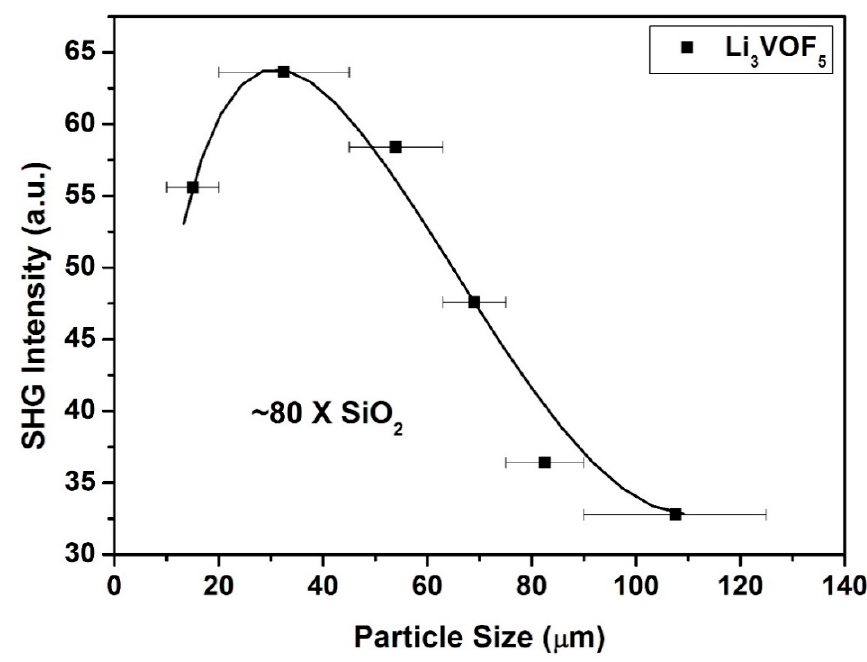
Figure 6. Second-harmonic-generation (SHG) measurements of the compound Li 3 VOF 5 ( II ).